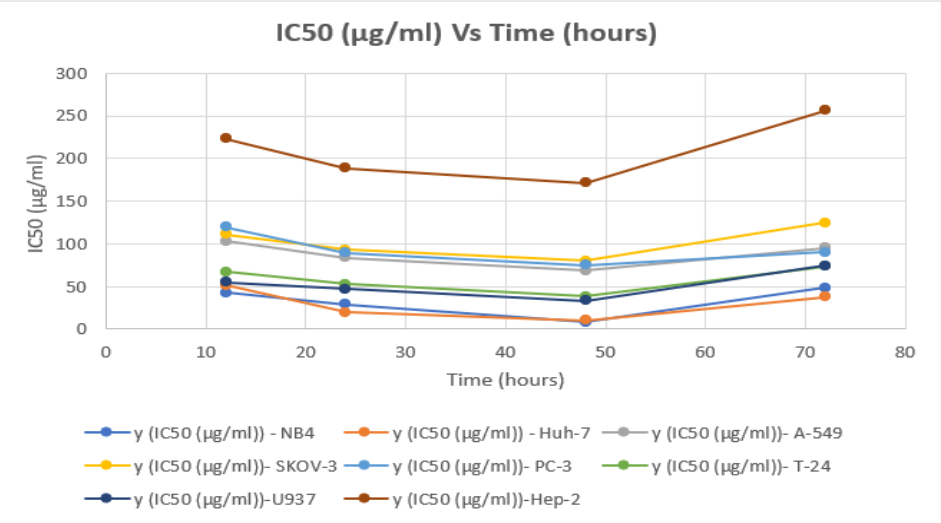
Figure 2. The inhibitory effect prism of P. amygdalus var . amara at different concentrations (5–300 µ g/mL). Table 3 and Figure 3 show the inhibitory impact of P. amygdalus var . amara on right cancer cell lines at several concentrations (5–300 µ g/mL). Table 2. Microscopic examination-stained cell line study of P. amygdalus alcoholic seed extractions .